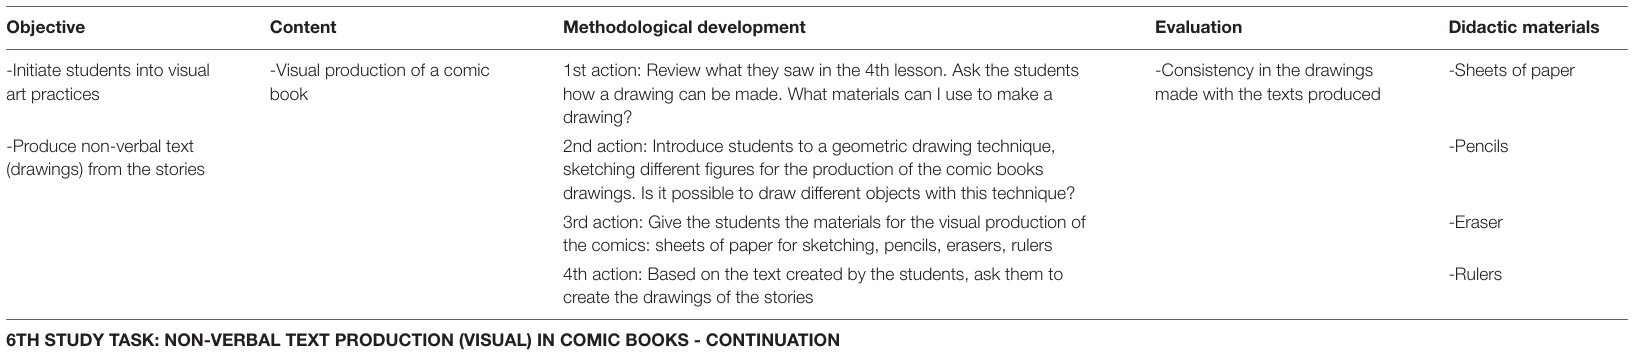
5TH STUDY TASK: NON-VERBAL TEXT PRODUCTION (VISUAL) IN COMIC